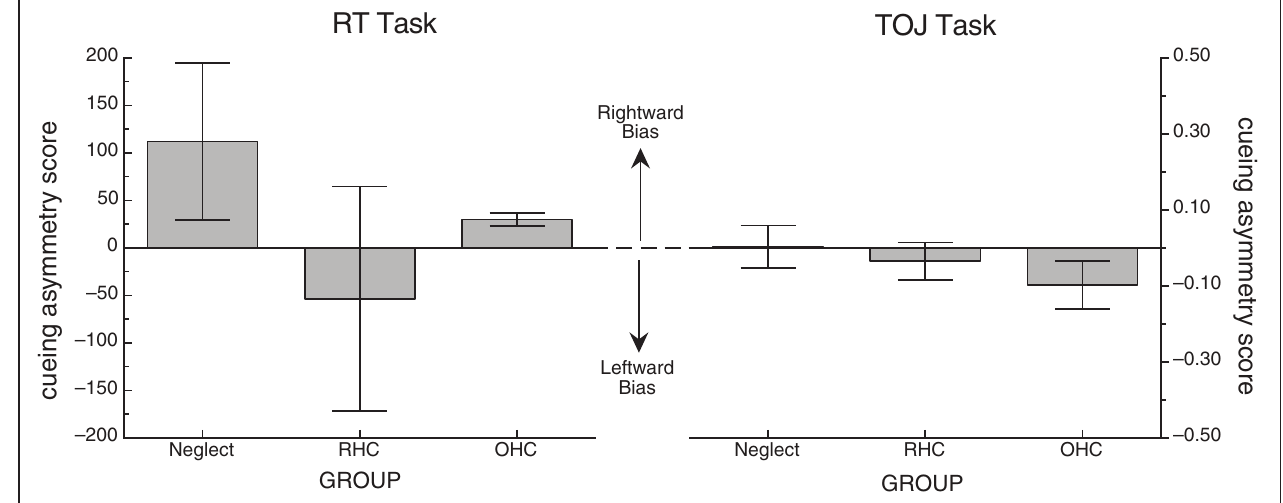
FIGURE 3 | Mean cueing asymmetry score for each of the two tasks. Error bars represent + / − the standard error of the mean for each group. In both cases, positive scores represent a rightward bias (the direction of the standard disengage deficit) and negative scores represent a leftward bias.